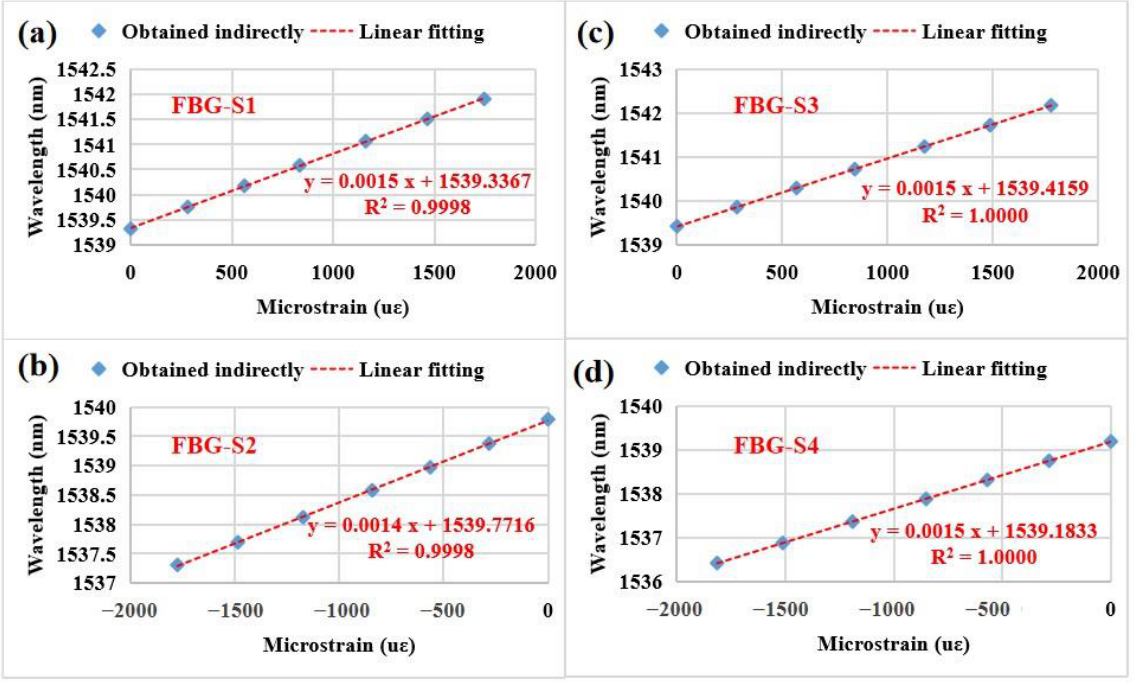
Figure 10. Central wavelengths of the four FBG strain sensors as a function of microstrains: ( a ) FBG-S1, ( b ) FBG-S2, ( c ) FBG-S3, ( d ) FBG-S4.